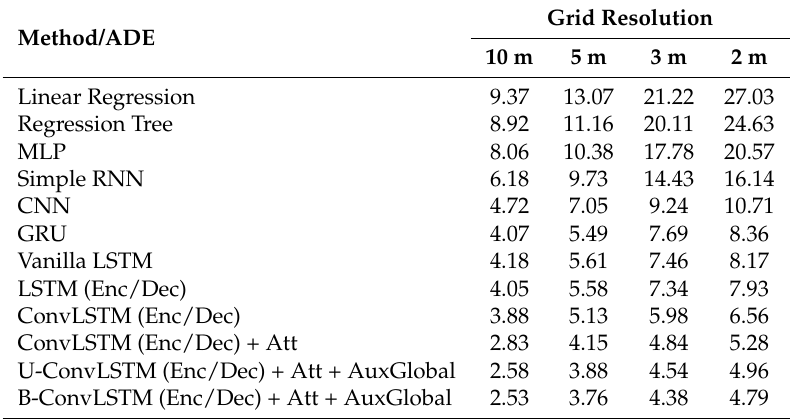
Table 1. Average Displacement Error (ADE) loss comparison of methods at different level of grid resolution (10